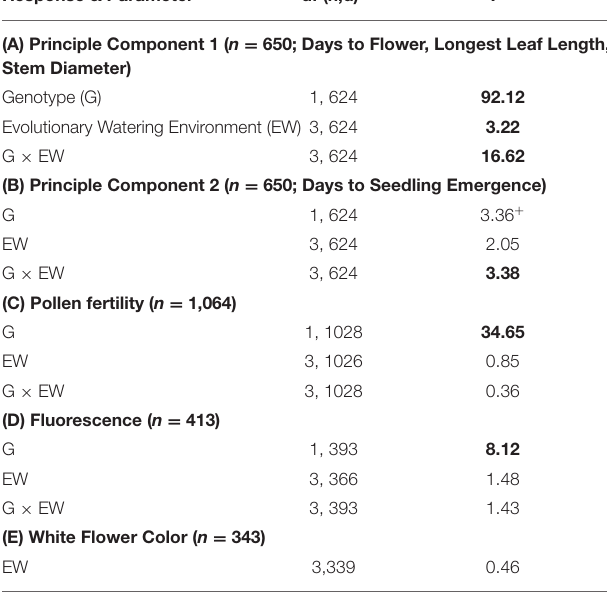
TABLE 2 | Mixed-model ANOVA of mean phenotypic trait values (A) principle component 1, (B) principle component 2, (C) pollen fertility, and (D) chlorophyll fluorescence (proxy of water-use-efficiency).